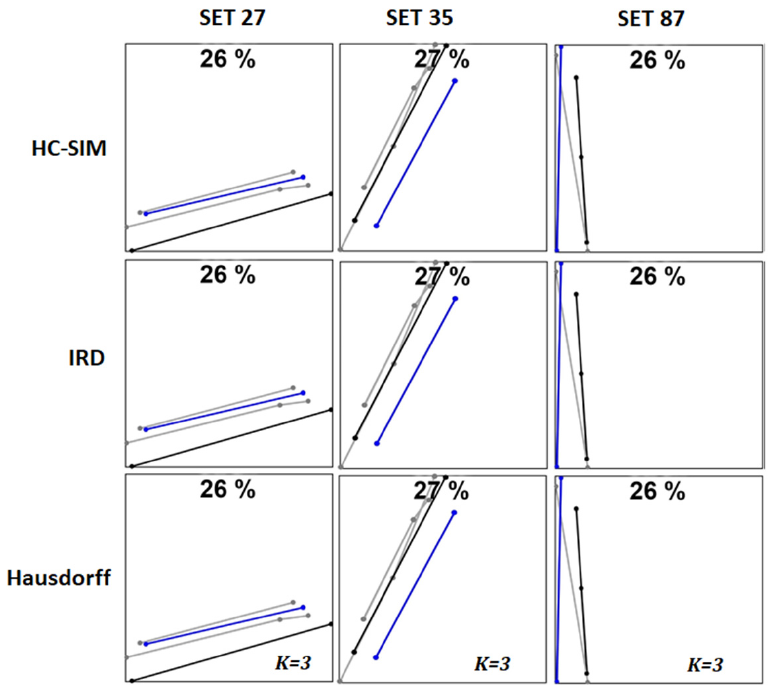
Figure 12. Examples where medoid provides low score with the three best-performing distance measures. The number of trajectories is very small in all cases: k = 3. measures. The number of trajectories is very small in all cases: k =